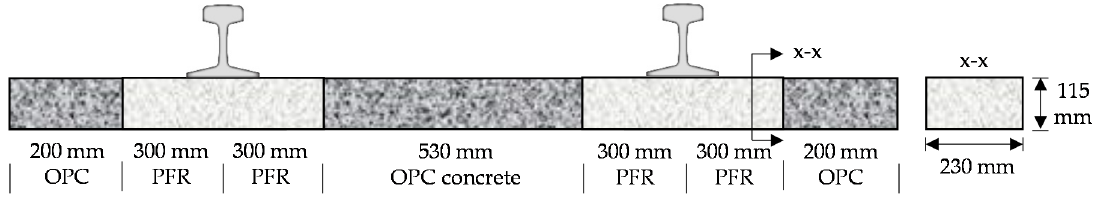
Figure 10. Proposed final design of polymer sleeper (based on Concept-2).